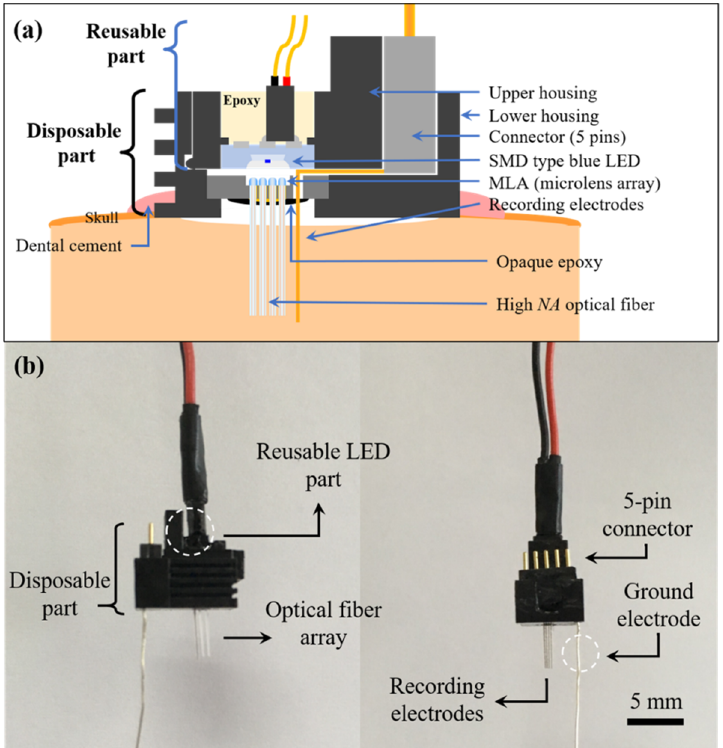
Figure 3. ( a ) Conceptual diagram of the proposed system for optical stimulation and electrophysio- logical recording; ( b ) fully assembled micro-electro-mechanical systems optrode array (MOA).